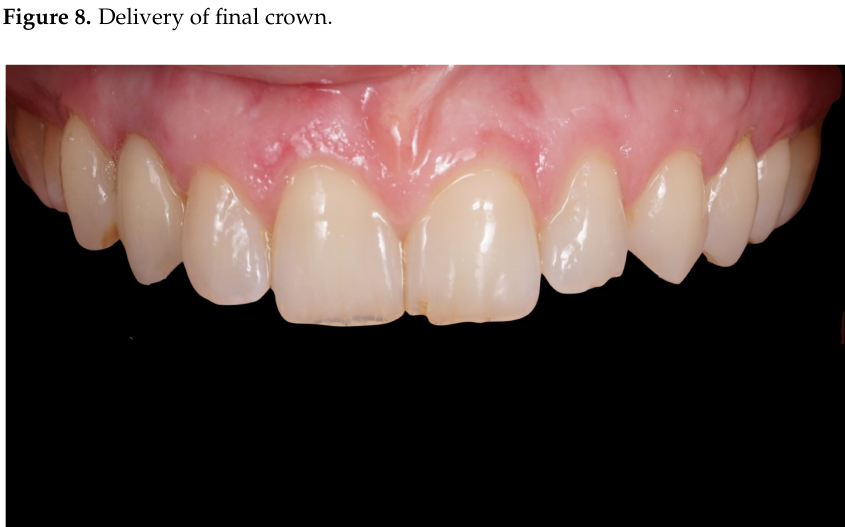
Figure 9. Definitive crown after 1 year of follow-up, frontal